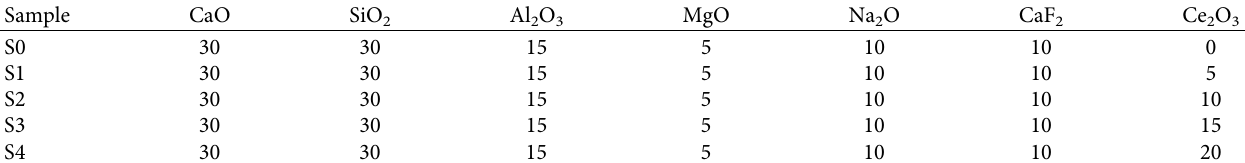
Table 3: Chemical composition of slag samples in each experimental heat (mass percentage).